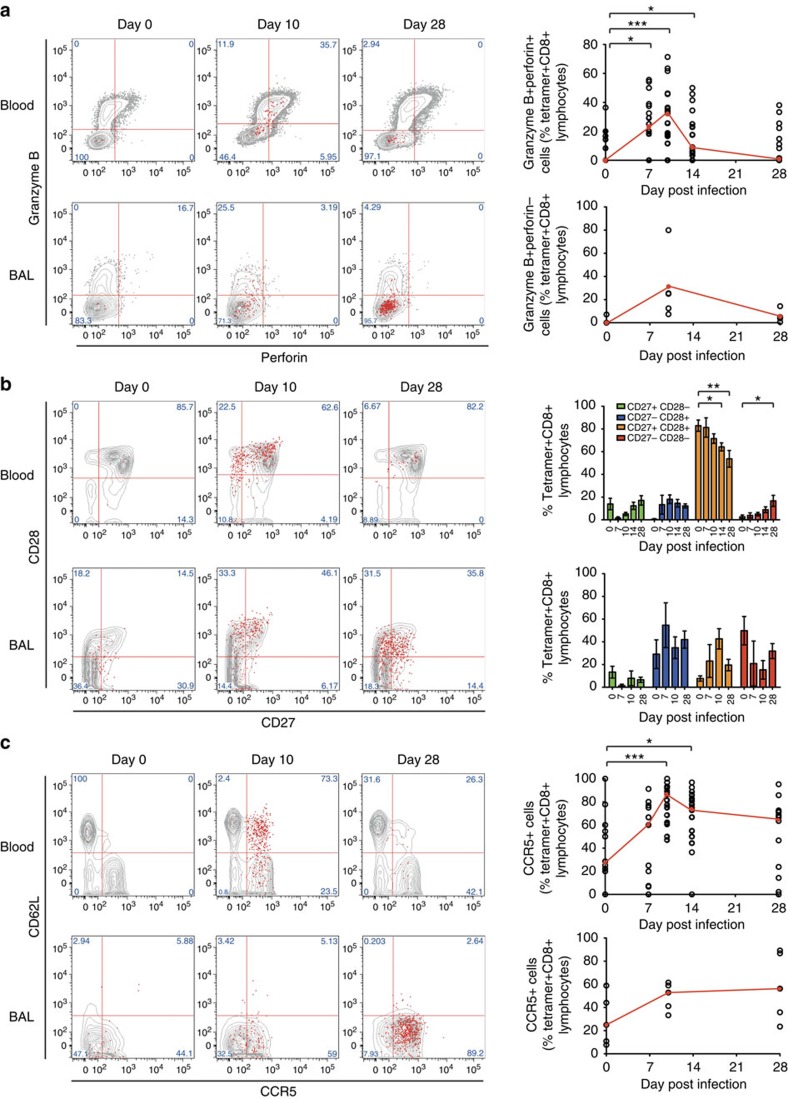
Reduced expression of cytotoxicity and co-stimulatory markers by RSV-specific CD8+ T cells in the airway.Tetramer+ CD8+ T cells in blood and BAL were co-stained for phenotypic markers. (a) Cytotoxicity molecules perforin and granzyme B are shown in blood (n=19) and BAL (n=5). Significant P values for two-tailed Wilcoxon matched pairs tests compared with baseline are shown in blood (day 7, P=0.0144; day 10, P=0.0009; and day 14, P=0.0413). (b) Co-stimulatory molecules CD27 and CD28 are shown in blood (n=19) and BAL (n=10). Mean±s.e.m. and significant P values for two-tailed Wilcoxon matched pairs tests compared with baseline are shown in blood for CD27+CD28+ cells (day 14, P=0.0454; day 28, P=0.0068) and CD27−CD28− cells (day 28, P=0.0144). (c) Homing receptors CCR5 and CD62L are shown in blood (n=19) and BAL (n=5). Significant P values for two-tailed Wilcoxon matched pairs tests compared with baseline are shown in blood (day 10, P=0.0009; day 14, P=0.0245). Throughout, representative plots from a single subject at day 0, 10 and 28 post infection are shown with tetramer+ cells as red dots and total CD8+ T cells in grey contours. Summarized data are shown for all RSV-infected subjects (who could be analysed using tetramers) with median frequencies shown in red. Abbreviated P values are shown: NS (not significant)=P>0.05, *P<0.05, **P<0.01.